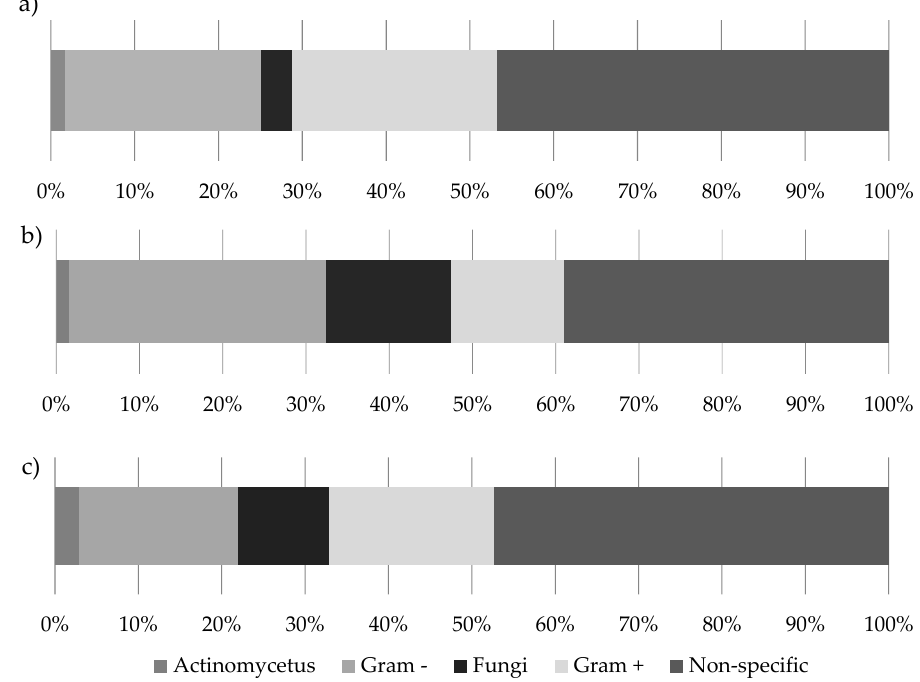
Figure 4. The microbial community composition of ( a ) 20 bird’s nest ferns from the Eden Project prior to experimental manipulation; ( b ) 20 bird’s nest ferns after 6 months in the rain forest biome; ( c ) 20 natural bird’s nest ferns from Danum Valley.